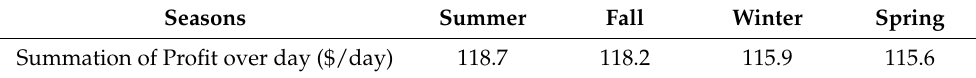
Table 4. The summation of profit of the model VPP for different seasons.